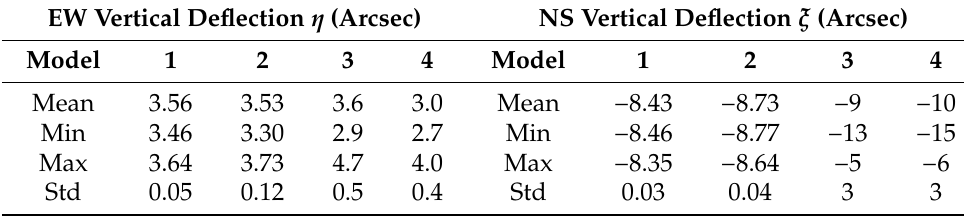
Table 6. Values of statistical indicators (minimum, maximum, mean and standard deviation) on the components of the vertical deviation calculated from 1000 measurement points on the studied profile. The number of significant figures was set according to the value of the standard deviation. The 4 models were found to be consistent with each other, with the exception of the north–south deflection components calculated from models 1 and 2. The values of the vertical deviation were calculated at the height of the profile studied with respect to the reference ellipsoid estimated at -1850 m. This estimate was determined by considering a depth of 1900 m below the geoid surface, which in this area is on average 50 m above the surface of the reference ellipsoid. The mean values derived from these models represent reasonable estimates of the vertical deflection components on the profile